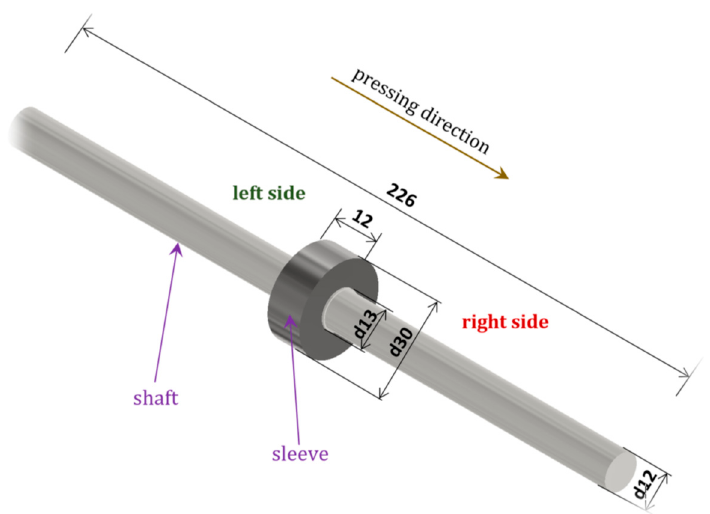
Figure 1. View and dimensions of the shaft/sleeve forced-in joint.